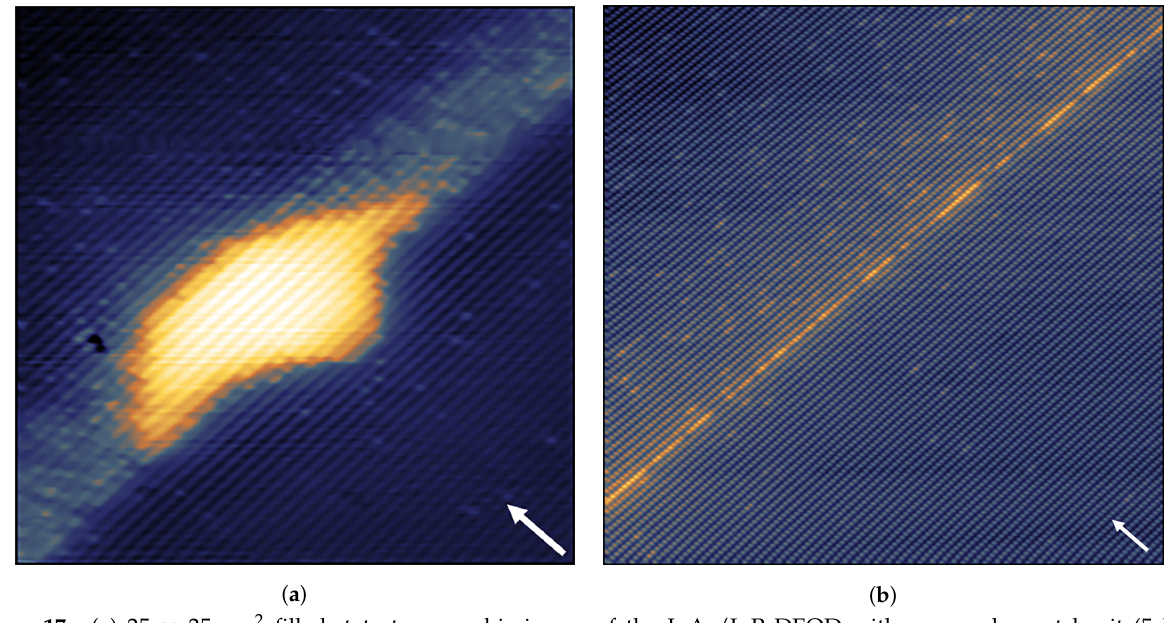
Figure 17. ( a ) 25 × 25 nm 2 filled-state topographic image of the InAs/InP DEQD with a very deep etch pit (5 BLs); ( b ) 40 × 40 nm 2 filled-state topographic image of the discontinuous wetting layer in InAs/InP DEQDs. The arrow indicates the growth direction